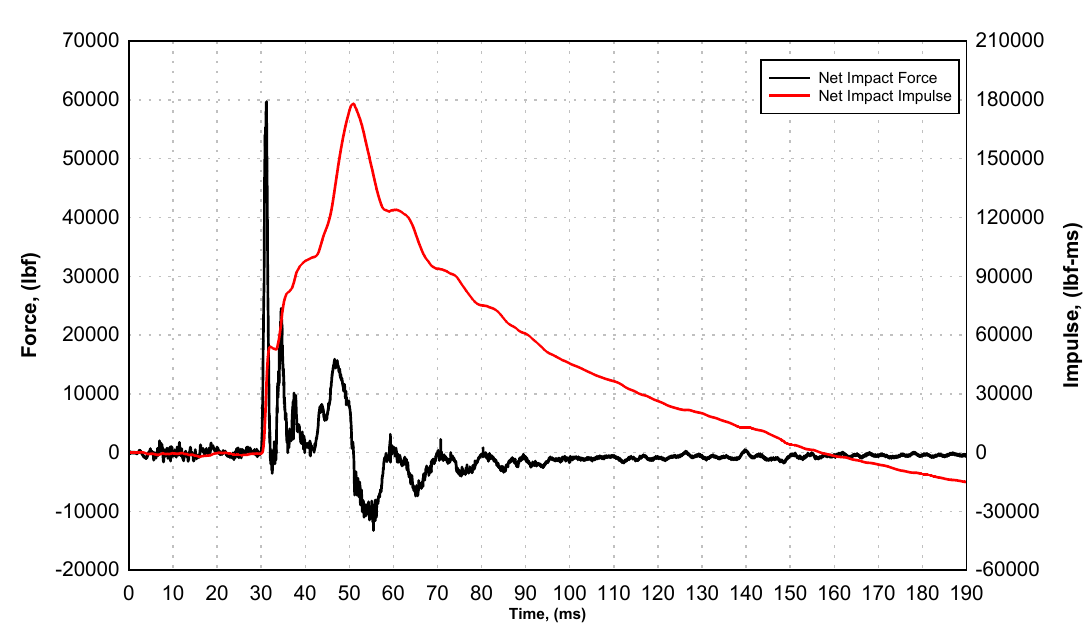
Figure 12. Summed force histories for CLT5-10 specimen.